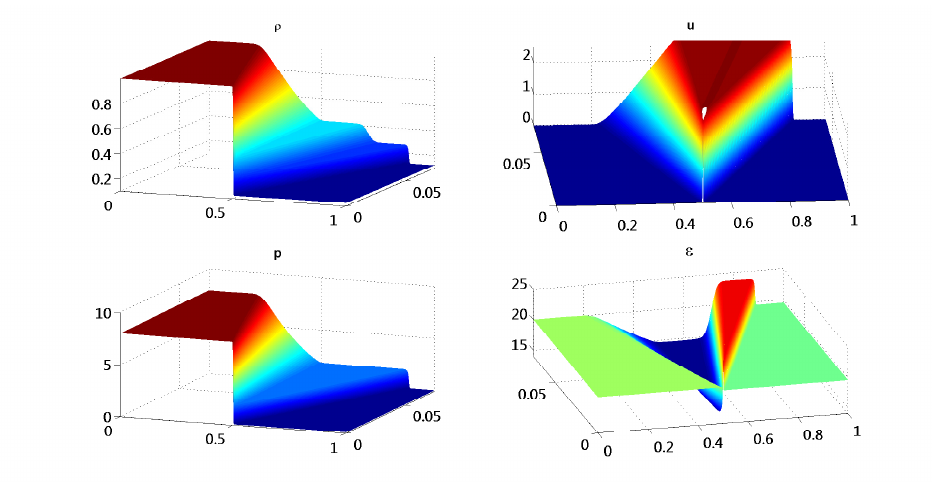
Figure 2. Test 1 (the stiffened gas): the space–time graphs.